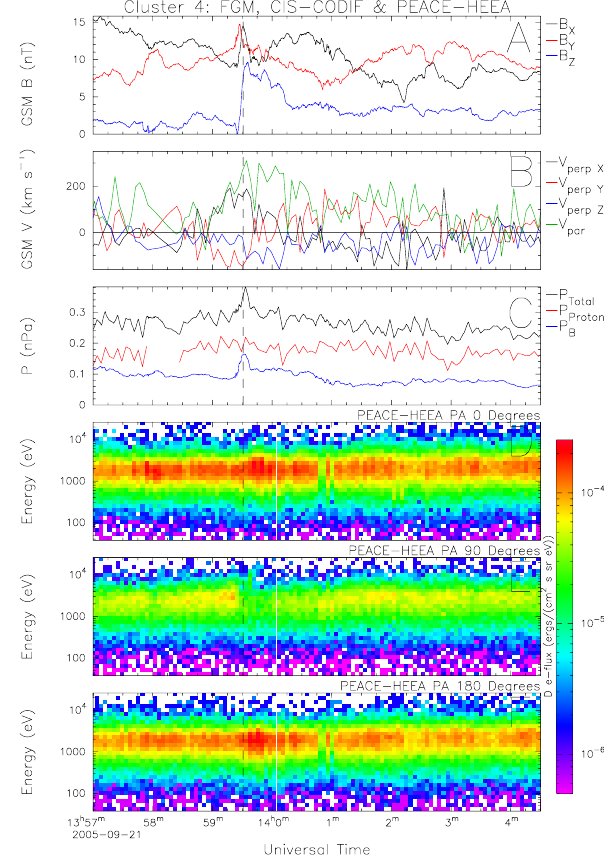
Fig. 7. C3 observations of the field dipolarisation and associated plasma features. Panel (A) shows GSM B X (black), B Y (red) and B Z (blue) from FGM, panel (B) GSM V ⊥ X (black), V ⊥ Y (red), V ⊥ Z (blue) and V // (green) for ions from CIS-HIA, panel (C) total (i.e. magnetic + ion) pressure (black), ion pressure (red) and mag- netic pressure (blue) and panels (D–F) energy time spectrograms from PEACE-LEEA for pitch angles of 0 ◦ , 90 ◦ and 180 ◦ , respec- tively. Note that the energy range for these PEACE spectrograms is different from those in the The vertical dashed line marks the entry of the spacecraft into the region of interest.